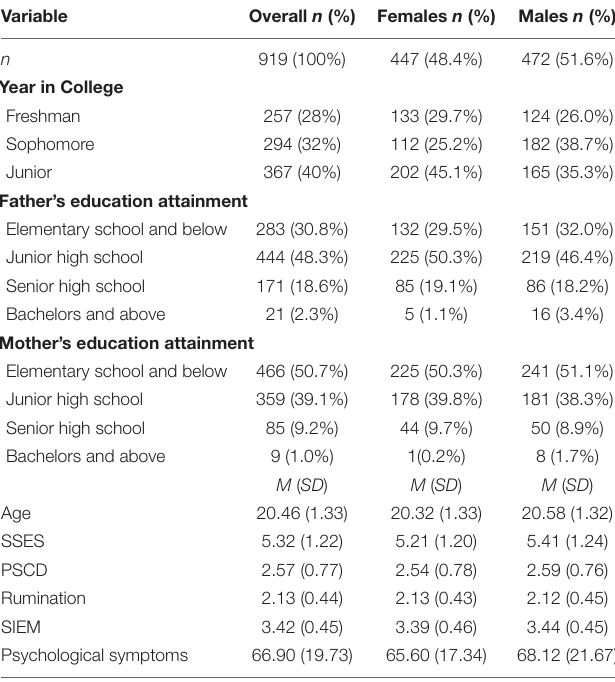
TABLE 1 | Sample demographics.